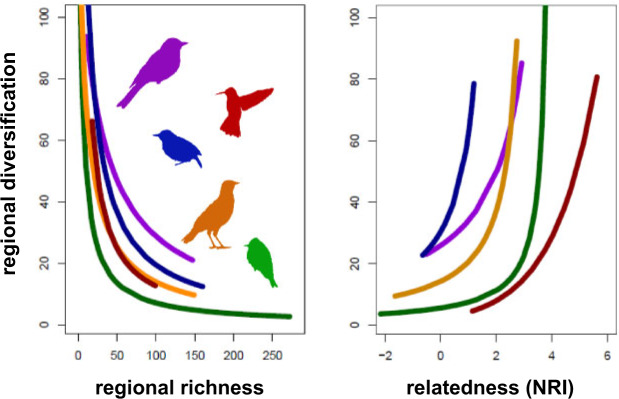
Diversification, richness, and possible competition across elevations. Species-poor highlands show fast diversification while species-rich lowlands show suppressed diversification (left panel). Moreover, suppressed diversification is coupled with strong signatures of possible competition within lowlands (NRI \documentclass[12pt]{minimal}
\usepackage{amsmath}
\usepackage{wasysym}
\usepackage{amsfonts}
\usepackage{amssymb}
\usepackage{amsbsy}
\usepackage{upgreek}
\usepackage{mathrsfs}
\setlength{\oddsidemargin}{-69pt}
\begin{document}
}{}$<<$\end{document} 0) (right panel). Taxon-specific silhouettes and color-coding correspond with the preceding figures. The vertical axis indicates relative differences in diversification. Full results, including the absolute differences, regression lines, data points, and summary statistics for each taxon separately, are provided in the Supplementary Figures S38–S42 available on Dryad.